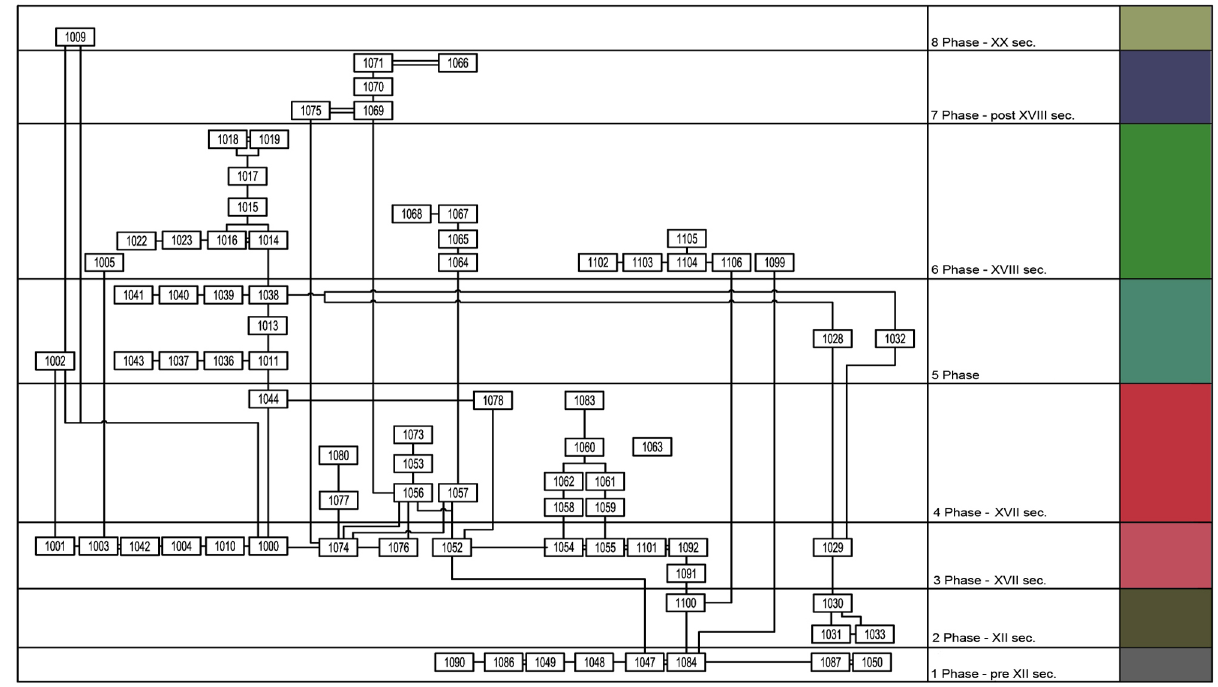
Fig. 7: Matrice of Harris of the south-western front (the negative SUs are not